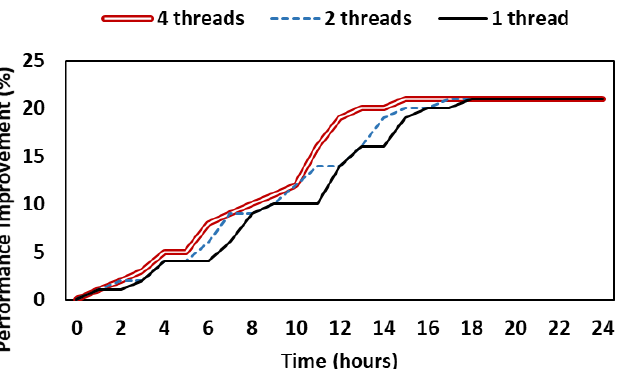
Figure 7. The degree of performance improvement according to time and number of threads in online learning.